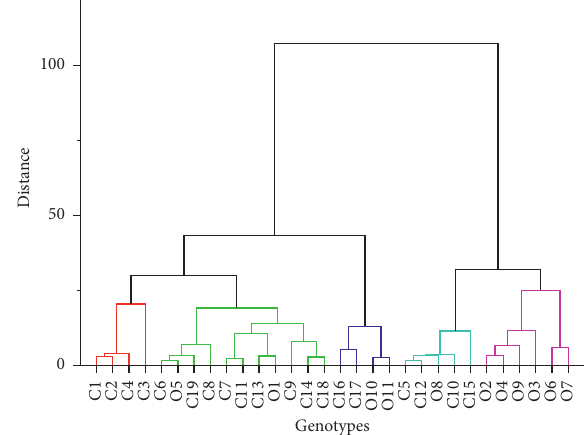
Figure 8: Dendrogram of the studied jute genotypes, obtained by cluster analysis (Ward and Euclidean distance) based on secondary metabolites and antioxidant